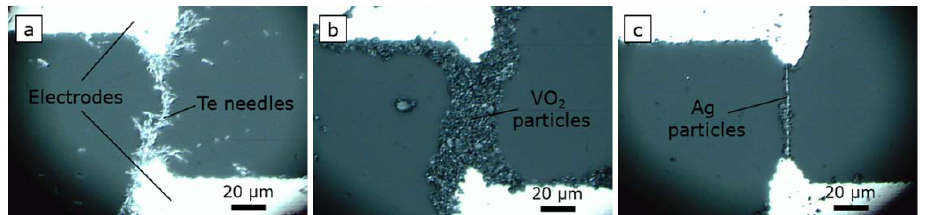
Figure 5. Optical microscopic pictures of dielectrophoretically aligned particles between electrodes: (a) tellurium needles, (b) vanadium dioxide, and (c) silver particles.